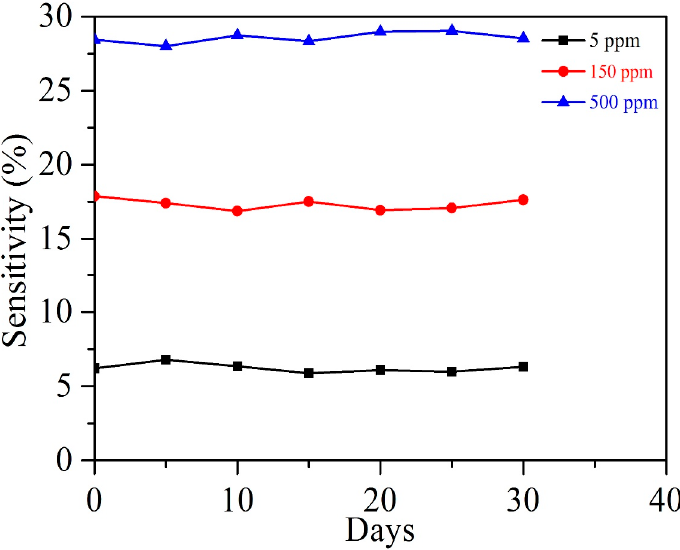
Figure 9. Long-term stability of the Ag–SnO 2 /rGO nanocomposite film sensor, measured every five days for over 30 days.